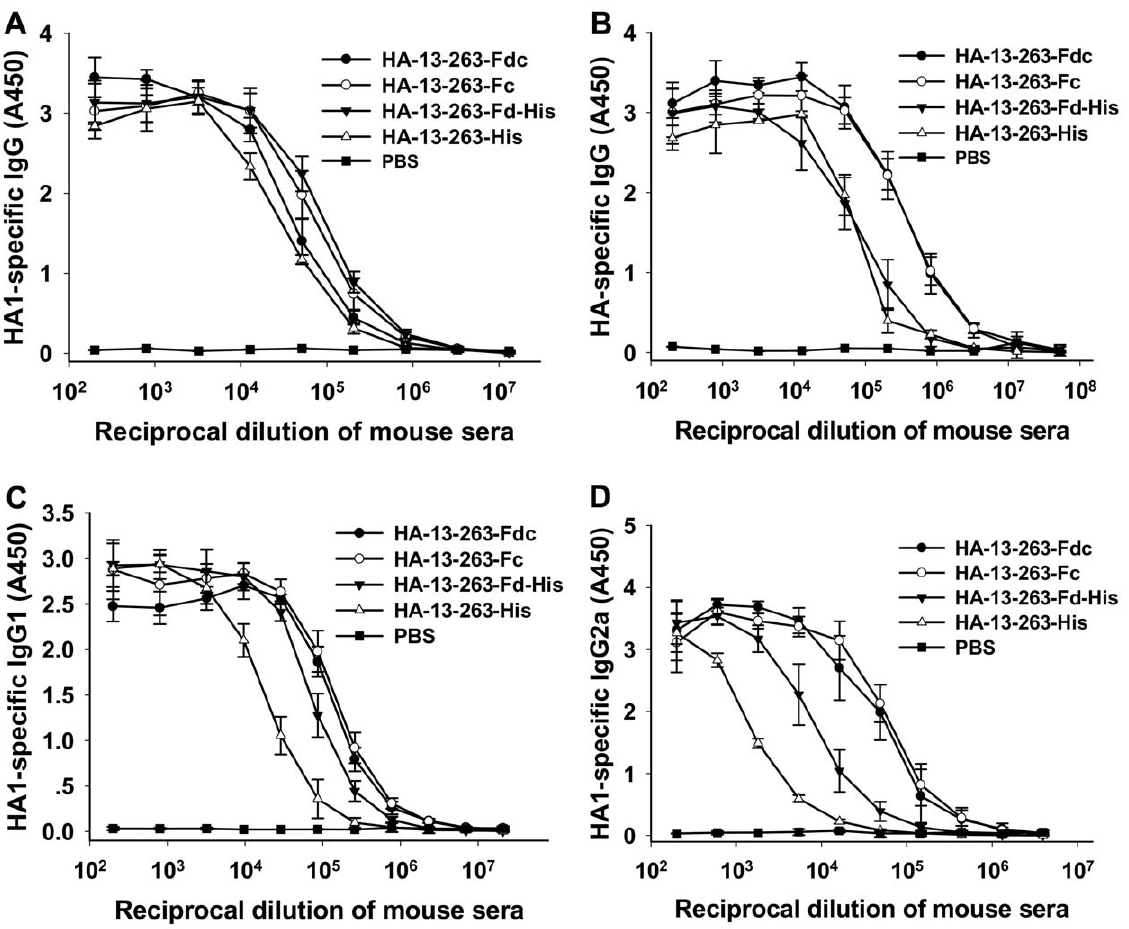
Figure 6. Detection of IgG antibody responses and subtypes by ELISA in HA-13–263 protein-vaccinated mouse sera. PBS was used as the negative control. Ability of IgG binding to HA1 (HA-13–263-His) protein (A) and full-length HA protein (B) was detected using mouse sera from 10 days post-last vaccination. The data are presented as mean A450 6 SD of five mice per group at various dilution points. Ability of IgG1 (C) and IgG2a (D) antibodies to bind to HA-13–263-His protein was detected using sera from 10 days post-last vaccination. The data are presented as mean A450 6 SD of five mice per group at various dilution points.